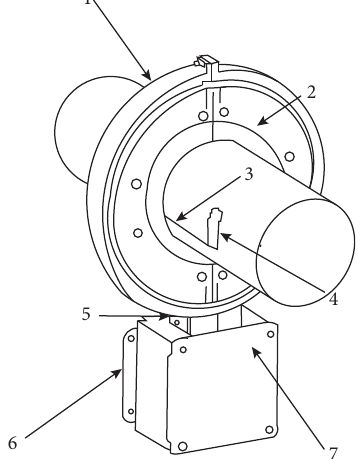
Figure 1: Component assembly diagram of the original torque telemetry system. 1-static power ring, 2-rotating ring, 3-strain gauge conductor, 4-welded strain gauge, 5-system state indicator lamp, 6-flange, 7-main control